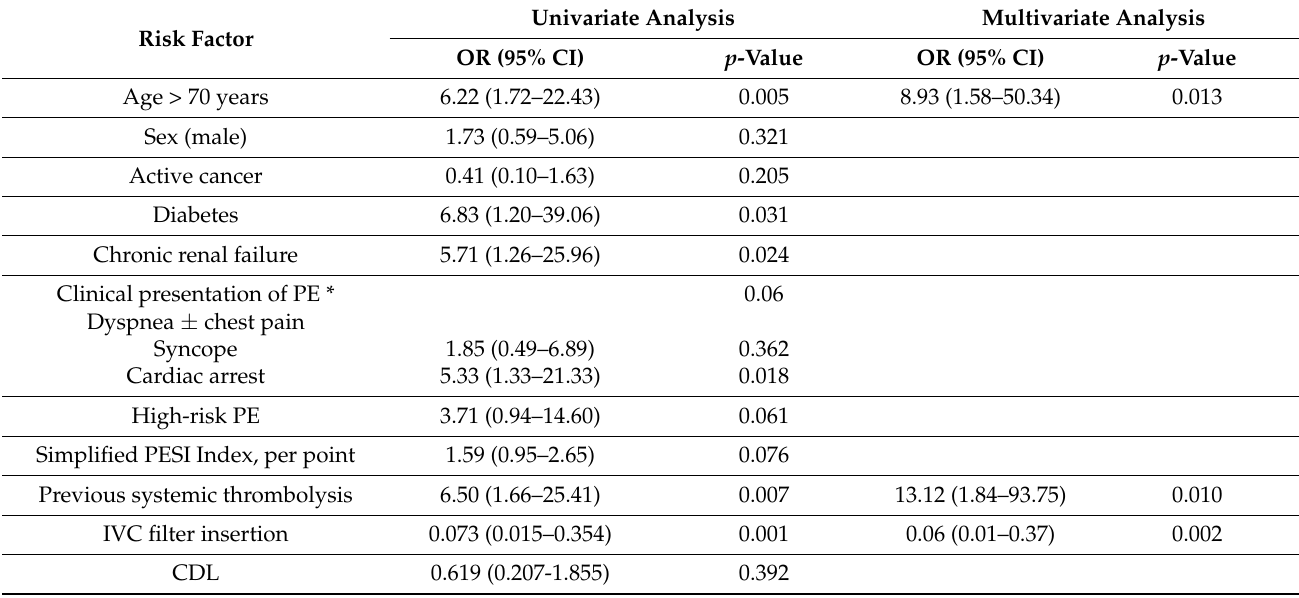
Table 4. Factors associated with in-hospital PE-related mortality.